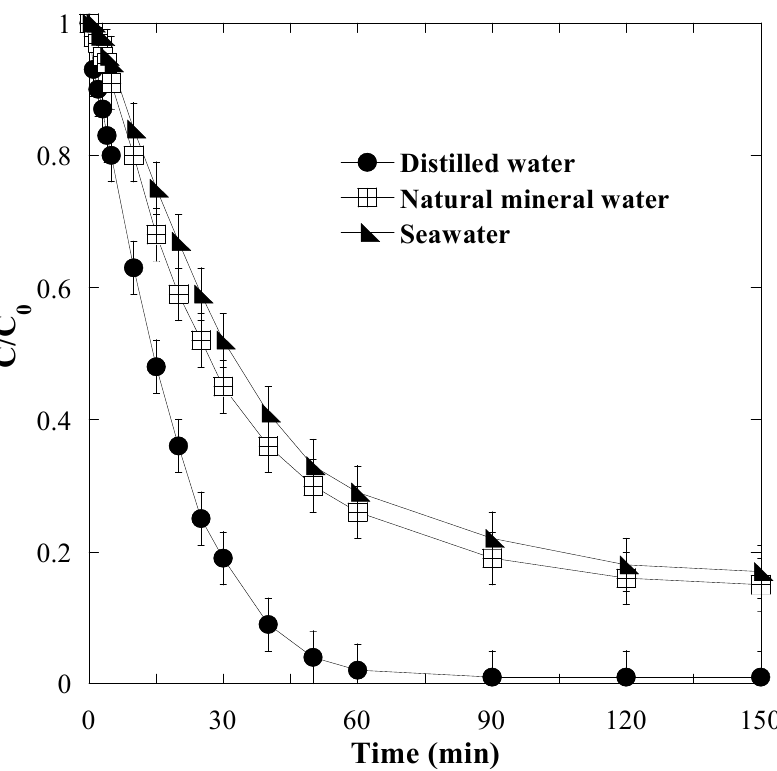
Figure 10. Effect of water matrix on the A010 degradation ([AO10] 0 = 50 mg/L, 20 ± 1 °C, [IO 4 − ] = 3 mM, irradiation intensity: 15 mW/cm²).